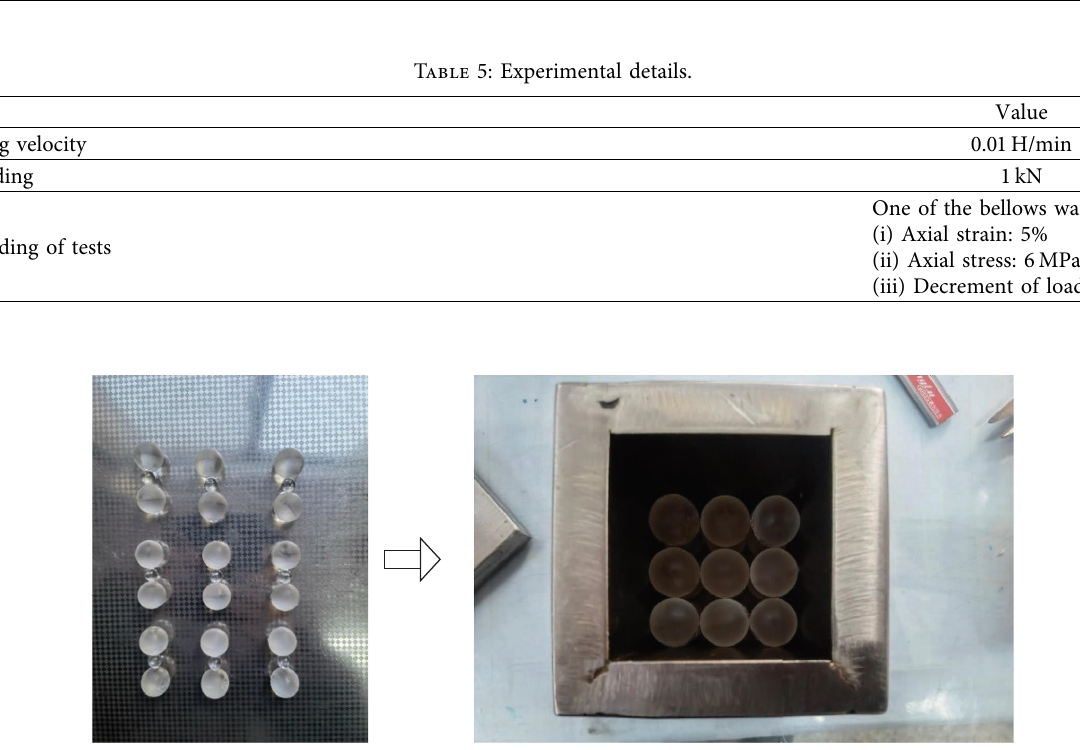
Figure 4: Pack with breakable PMMA